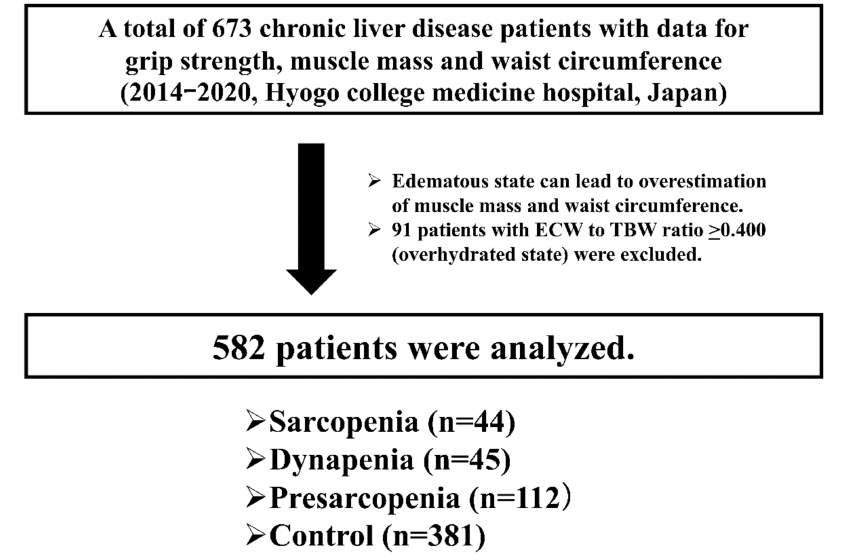
Figure 1. Patient flow chart in this